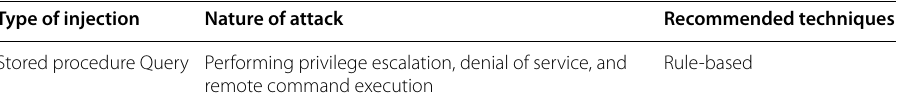
Table 5 Stored procedure query [54] Type of injection Nature of